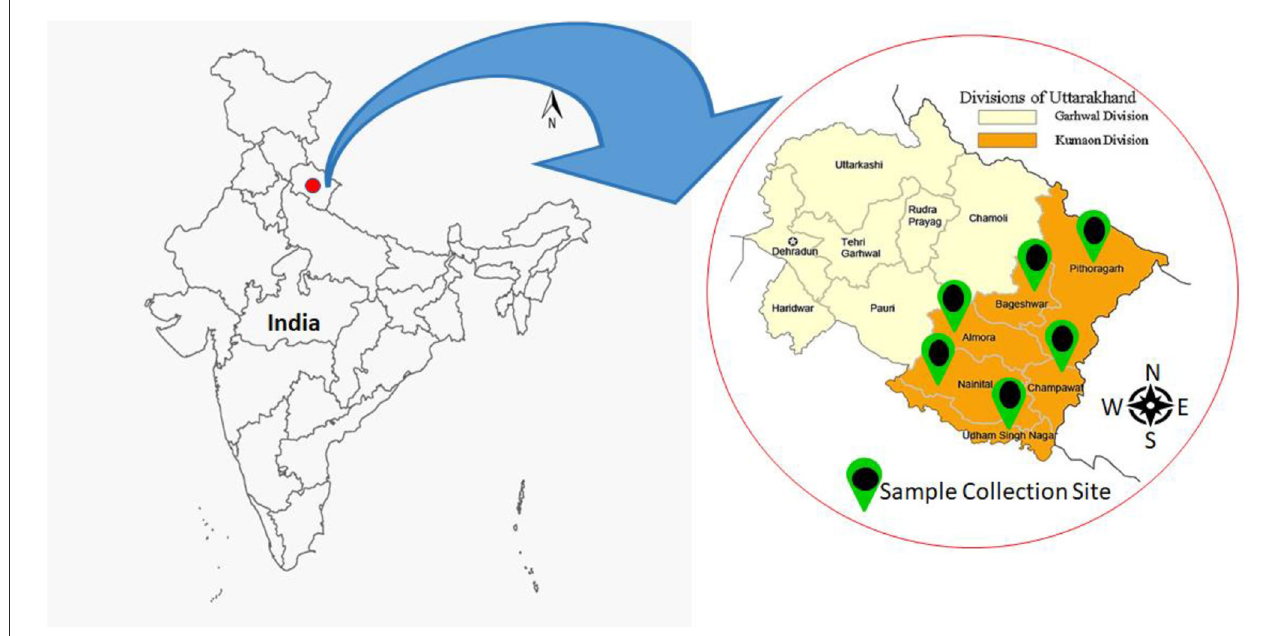
FIGURE1 Map depicting the various geographical locations in the Kumaon region where samples were